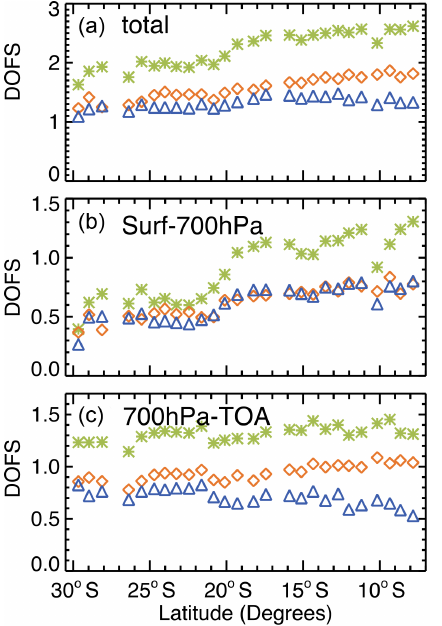
Figure 5. Degrees of freedom for CO measurements from CrIS, along with the synthetic TROPOMI alone and joint CrIS and TROPOMI measurements over the biomass burning region. Green stars are the DOF for joint TROPOMI and CrIS; gold diamonds are for the DOF for CrIS; and blue triangles are for DOF from TROPOMI